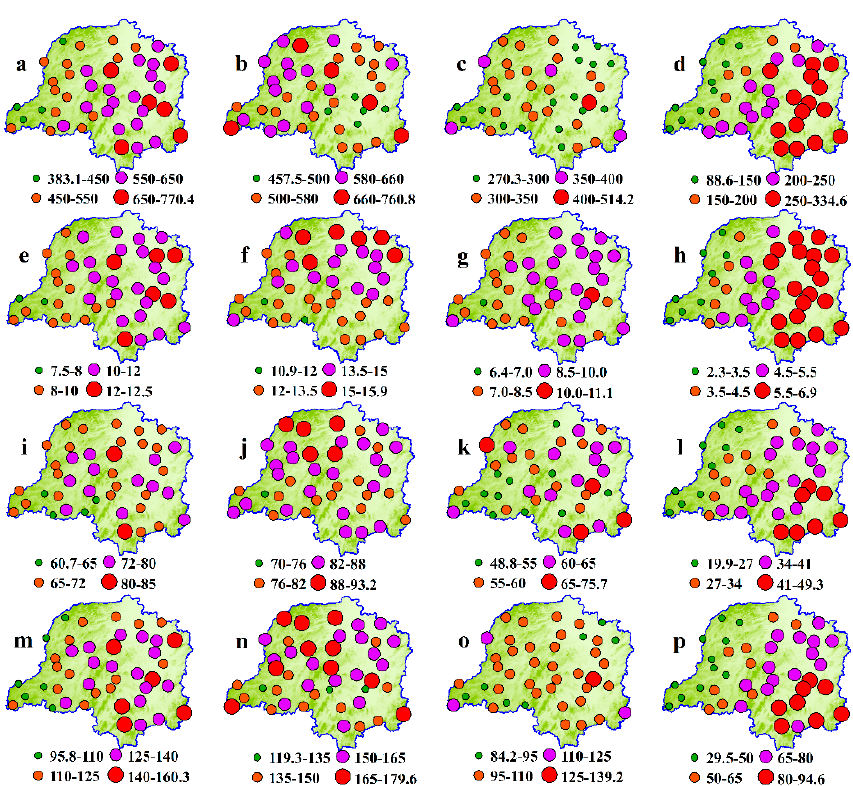
Figure 3. Distribution of the 5-year return levels for the four precipitation indices. ( a – d ): the 5-year return levels for total seasonal precipitation amount (R 5 ) in spring, summer, autumn and winter, respectively, and similarly the ( e – p ) shows the 5-year return levels for the Ri 5 , Rx1 5 and Rx5 5 in the four seasons.